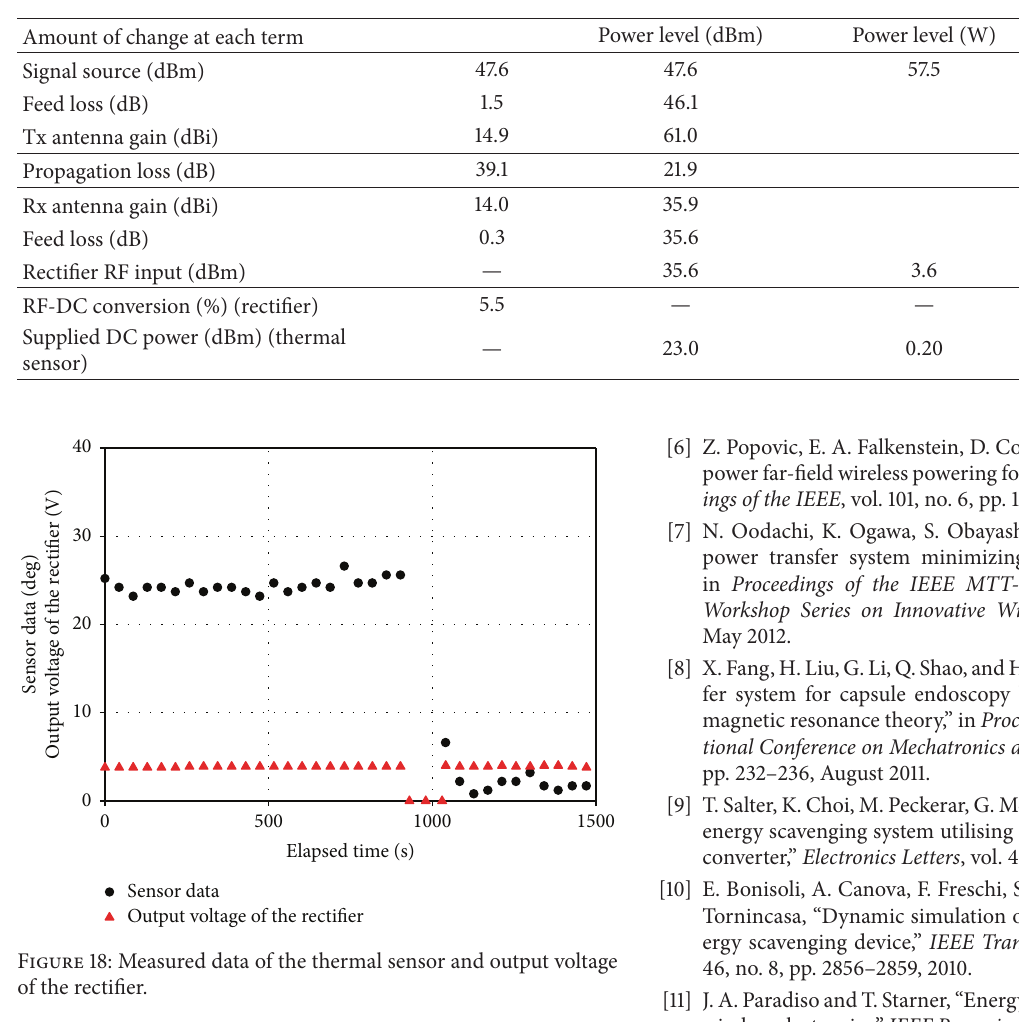
Table 3: Power diagram for the demonstration.